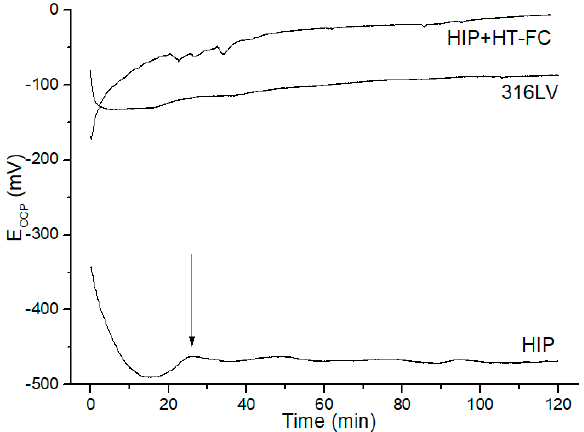
Figure 12. Open circuit potential versus time curves measured in Hank’s solution for as HIPped, HIP + HT–FC specimens, and 316LV steel (as reference material).